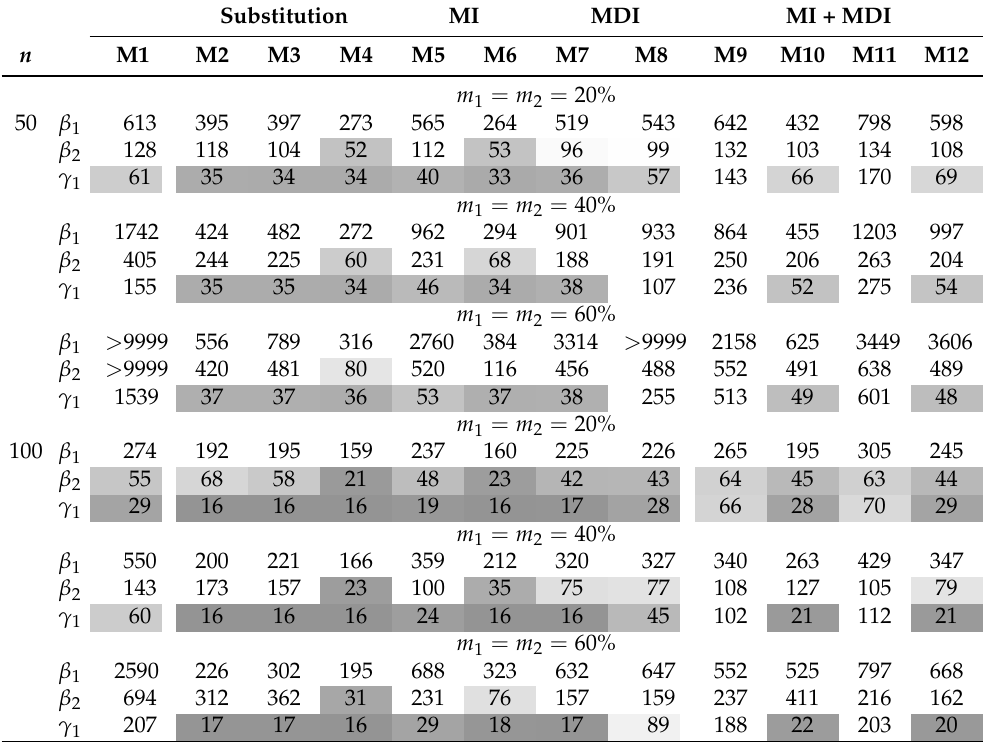
Table 4. Summary of the MSE ( × 1000) when covariates are correlated and X ∗ to lower LOD. M1 is complete case analysis; M2–M4 are the different variants of the substitution methods; M5–M6 are the different variants of the MI methods; M7–M8 are the different variants of the MDI methods; M9–M12 are the different variants of MDI-embedded MI (MI + MDI) methods. MSEs less than 0.1 are highlighted in gray, with darker tones corresponding to smaller